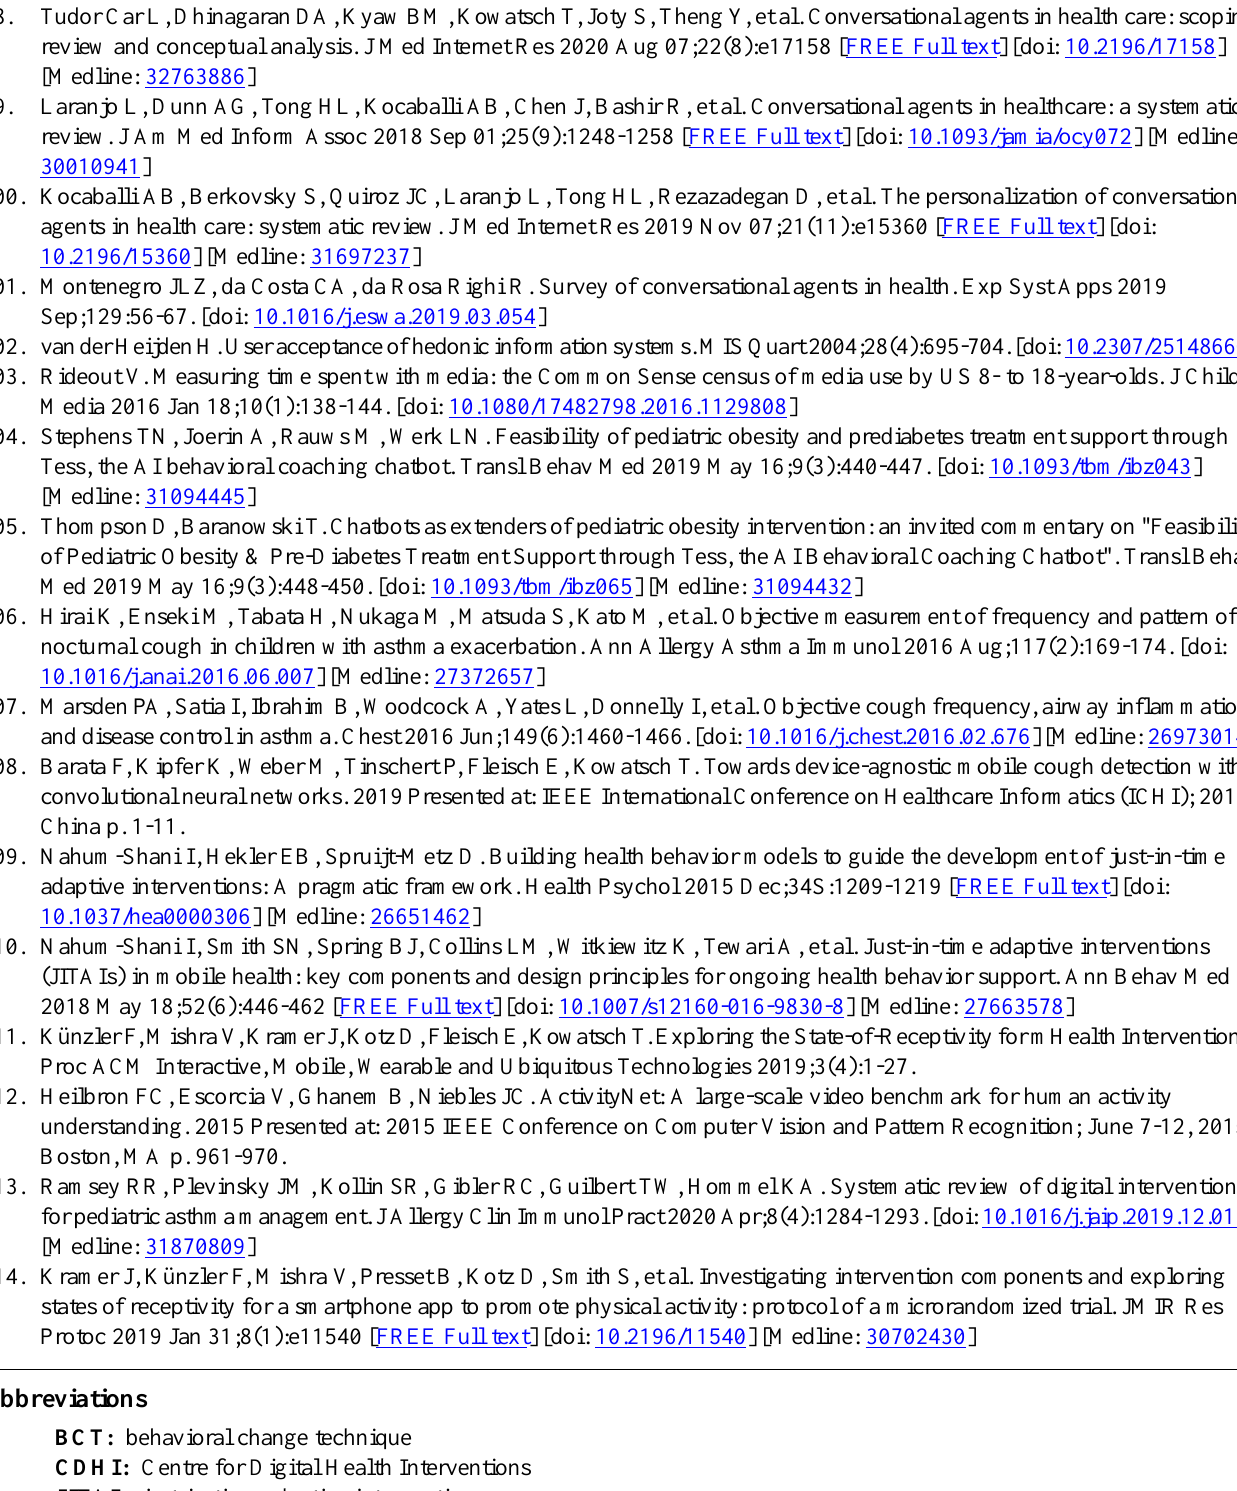
Abbreviations BCT: behavioral change technique CDHI: Centre for Digital Health Interventions JITAI: just-in-time adaptive intervention